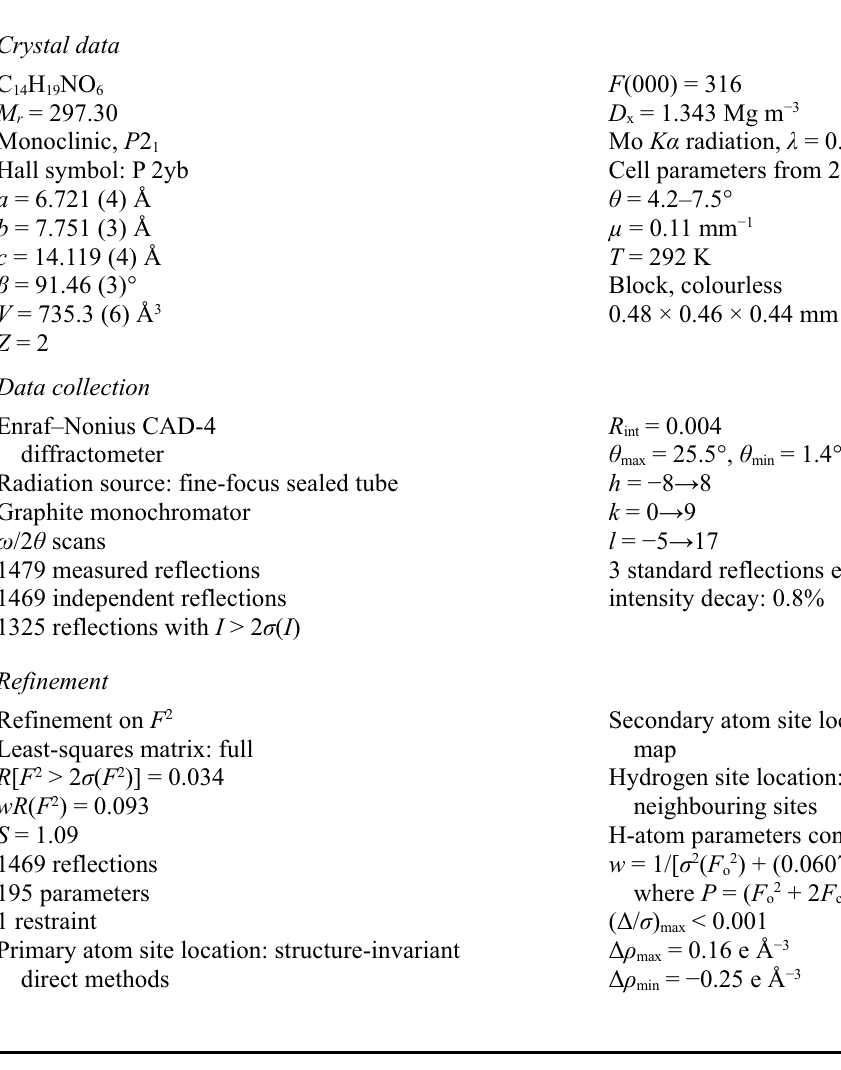
Figure 1 The molecular structure of the title compound, with displacement ellipsoids drawn at the 30% probability level. N-[4-( β